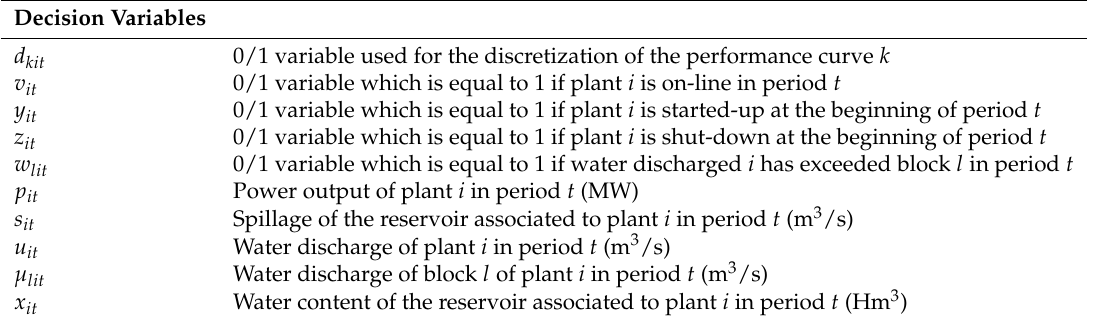
Table A3. Decision